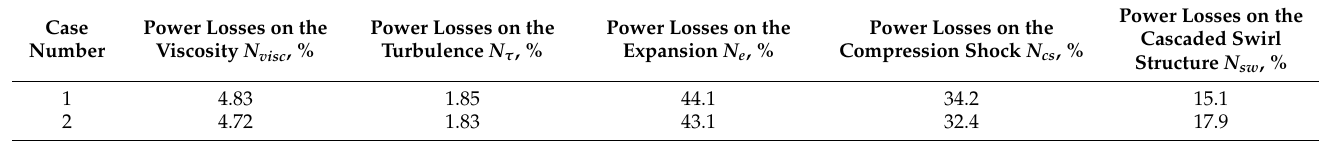
Table 12. Comparison of power losses obtained for SVT with Ar for 2 cases.